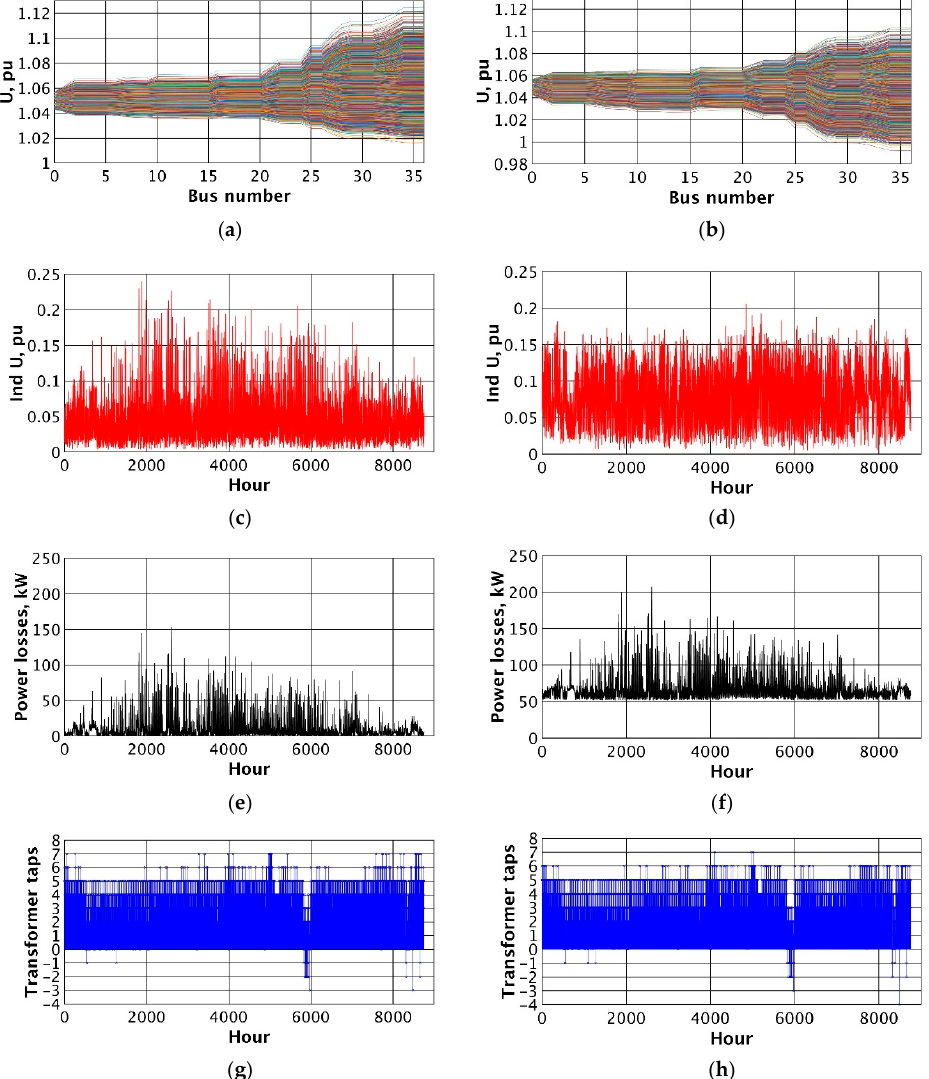
Figure 9. Annual effects of voltage control using the traditional method for two cases of reactive power generation in sources: cos φ = 1, Q G = − 0.4 P G ( a ) voltages in network nodes, cos φ = 1; ( b ) voltages in network nodes, Q G = − 0.4 P G ; ( c ) voltage quality indicator, cos φ = 1; ( d ) voltage quality indicator, Q G = − 0.4 P G ; ( e ) power losses, cos φ = 1; ( f ) power losses, Q G = − 0.4 P G; ( g ) OLTC position, cos φ = 1 ;( h ) OLTC position, Q G = − 0.4 P G.